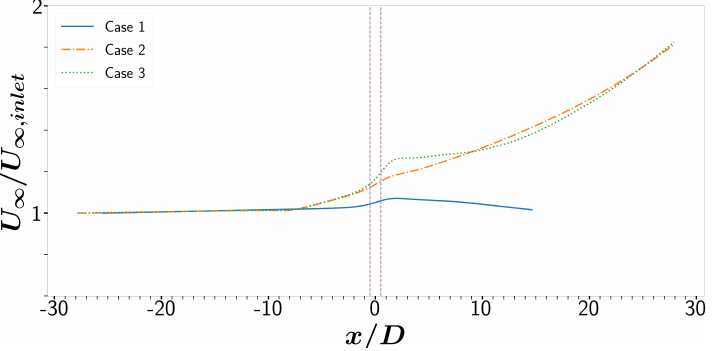
Figure 7. Freestream velocity ratio ( U ∞ / U ∞ , inlet ) for Case 1, Case 2 and Case